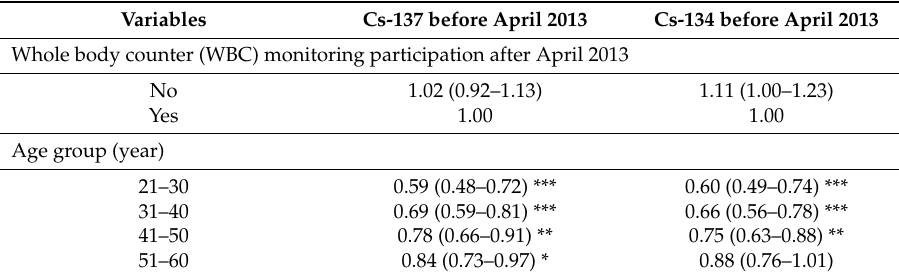
Table 4. Regression models to examine the potential differences in odds for detection of Cs-137 and Cs-134 before April 2013 between those who participated in the WBC monitoring and those who did not after